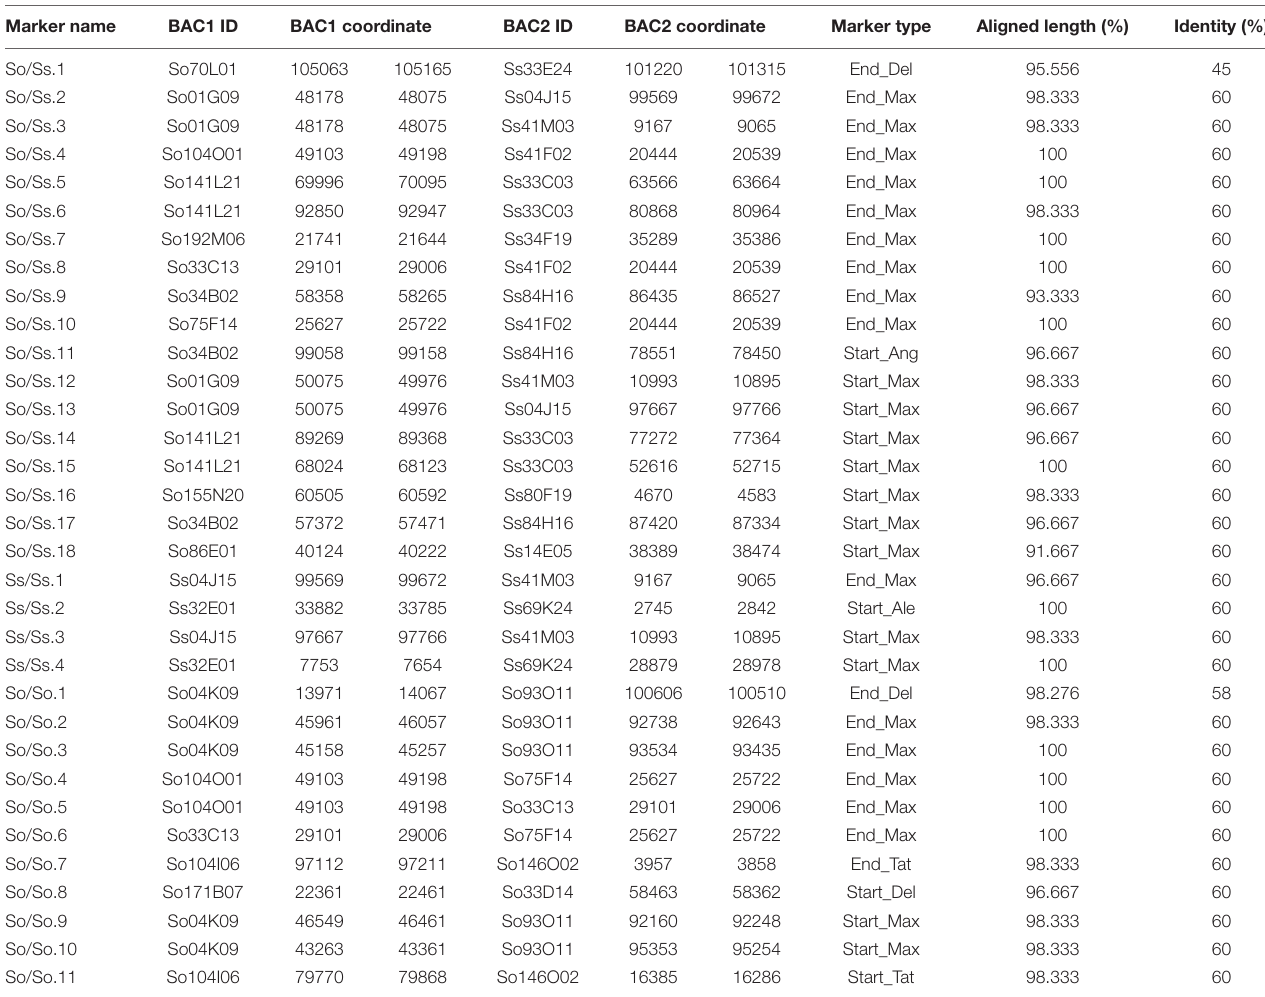
TABLE 3 | LTR junction marker identified in paired homologous BACs in Saccharum